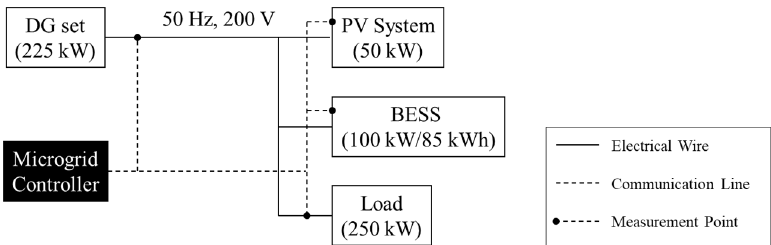
Figure 4. Microgrid configuration. The microgrid controller follows outputs of diesel generator (DG) set, battery energy storage system (BESS), photovoltaic (PV), and load and commands to PV and BESS according to functions 1 and 2.